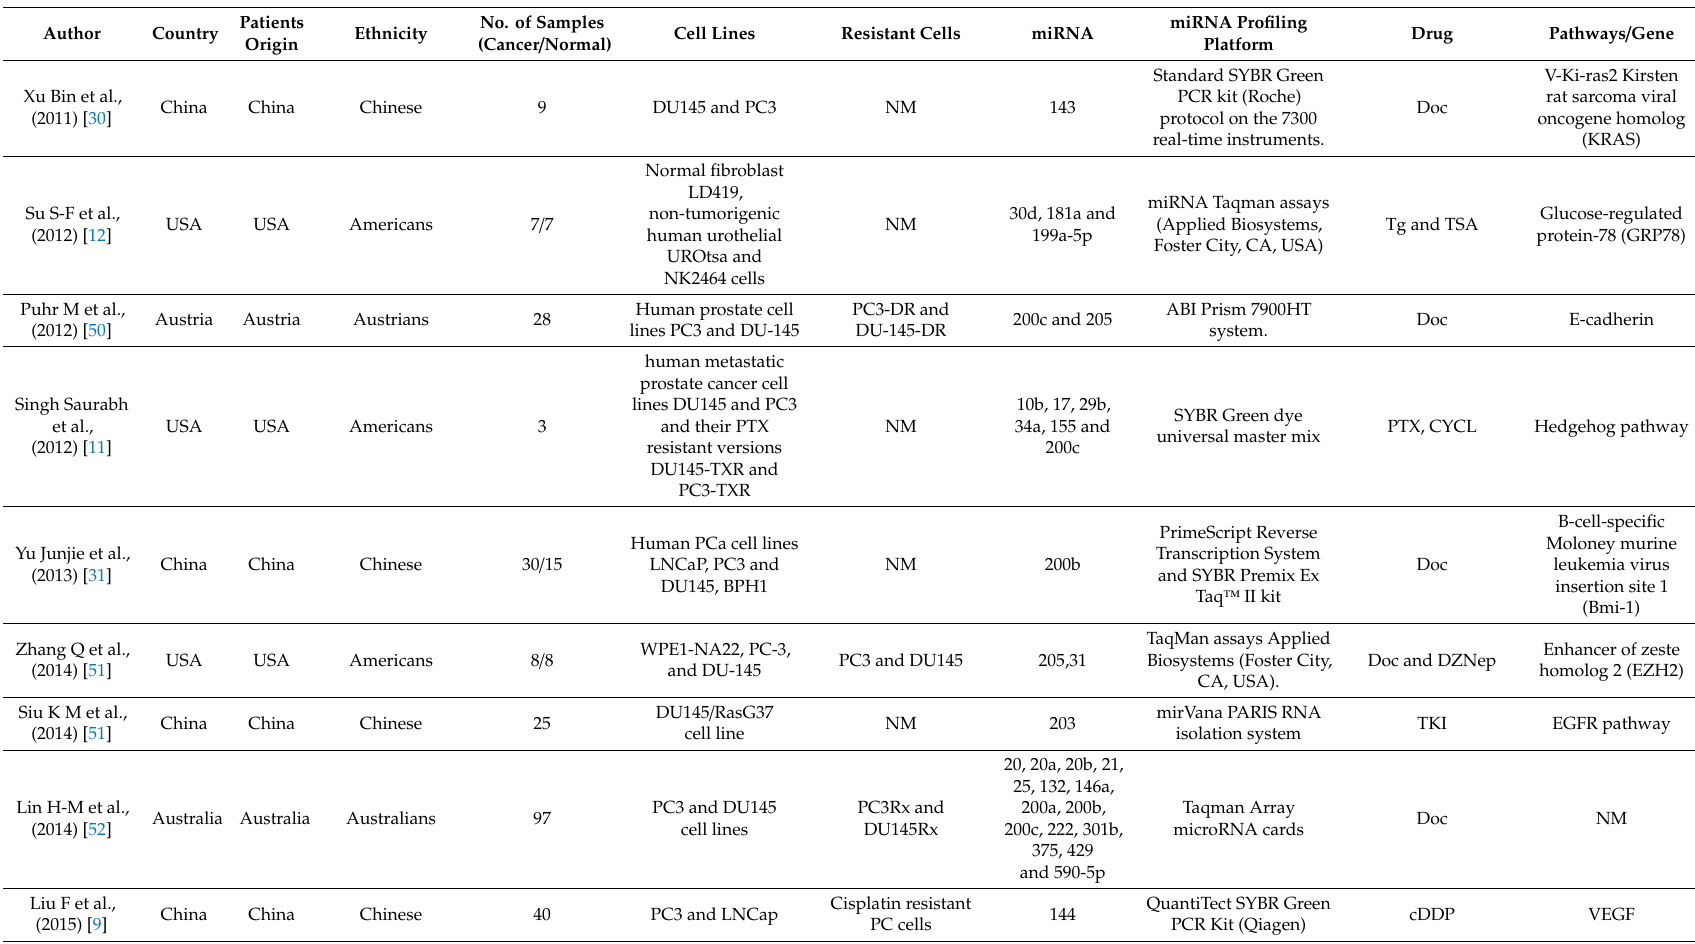
Table 1. Description of the 17 included